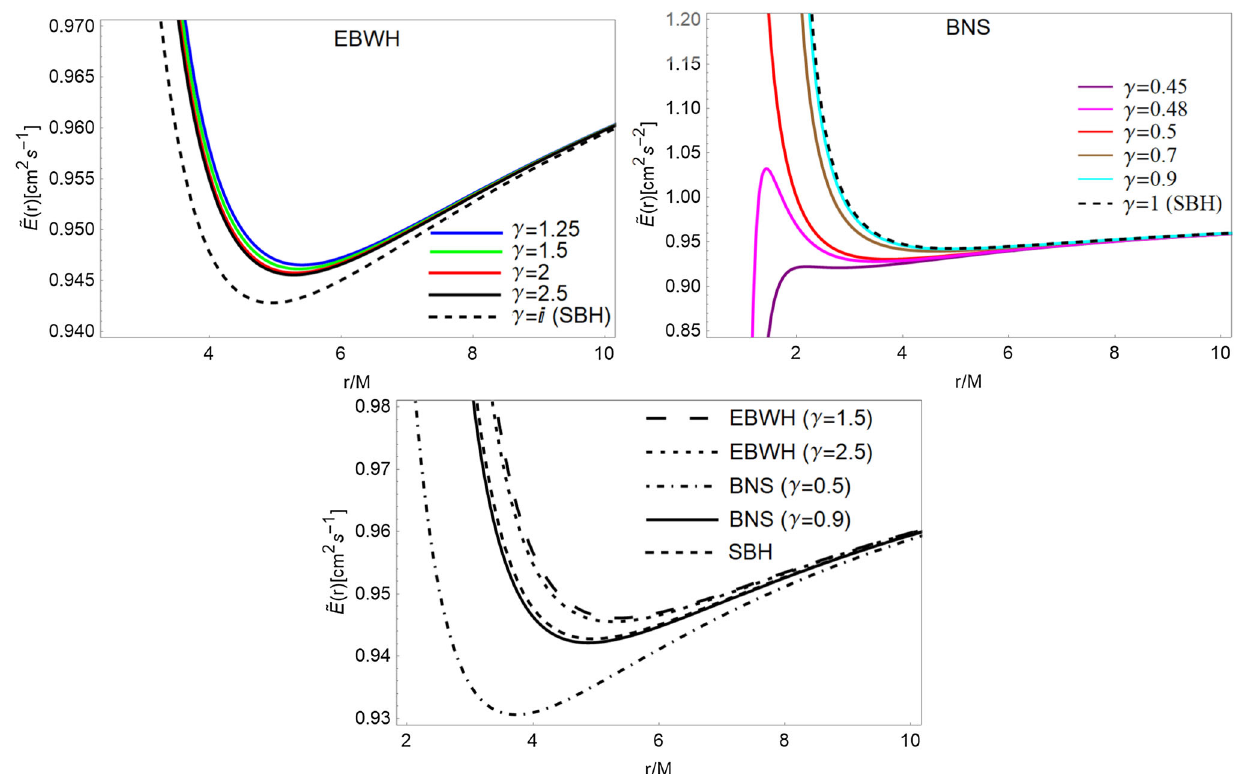
Fig. 3 The specific energy (cid:11) E ( r ) for EBWH, BNS and SBH for different values of γ